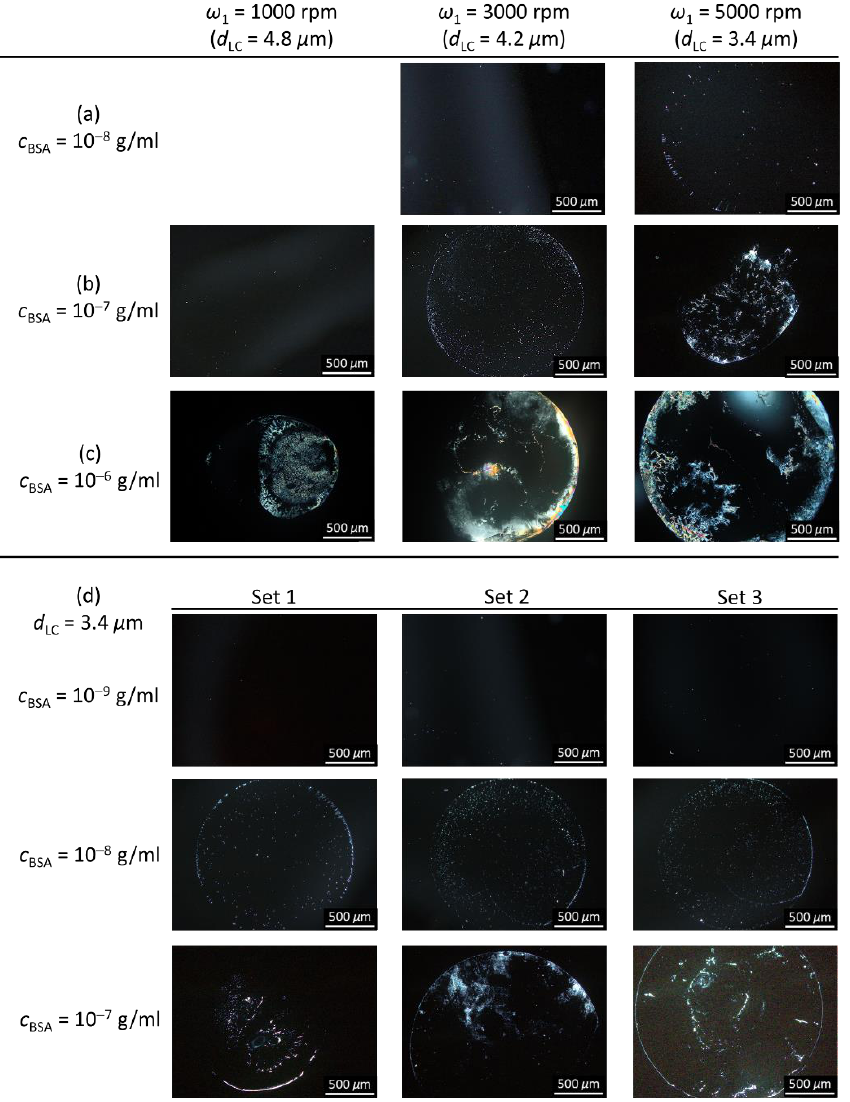
Figure 5. Polarized optical textures of spin-coated E7 films of various thicknesses in the presence of BSA. DMOAP-coated glass substrates with immobilized BSA at concentrations of ( a ) 10 − 8 , ( b ) 10 − 7 , and ( c ) 10 − 6 g/mL were spin-coated with the nematic LC E7 by varying the spin rate of the first step ( ω 1 ) of a two-step spin-coating procedure to form LC films with thicknesses d LC of 4.8, 4.2, and 3.4 μ m at ω 1 = 1000, 3000, and 5000 rpm, respectively. ( d ) Optical textures of three independent sets of experiments for 3.4 μ m-thick E7 films in the presence of BSA. Note that the brightness of optical textures in Figure 5a,b,d has been artificially increased by 40% to enhance the visibility. Scale bar, 500 μ m.